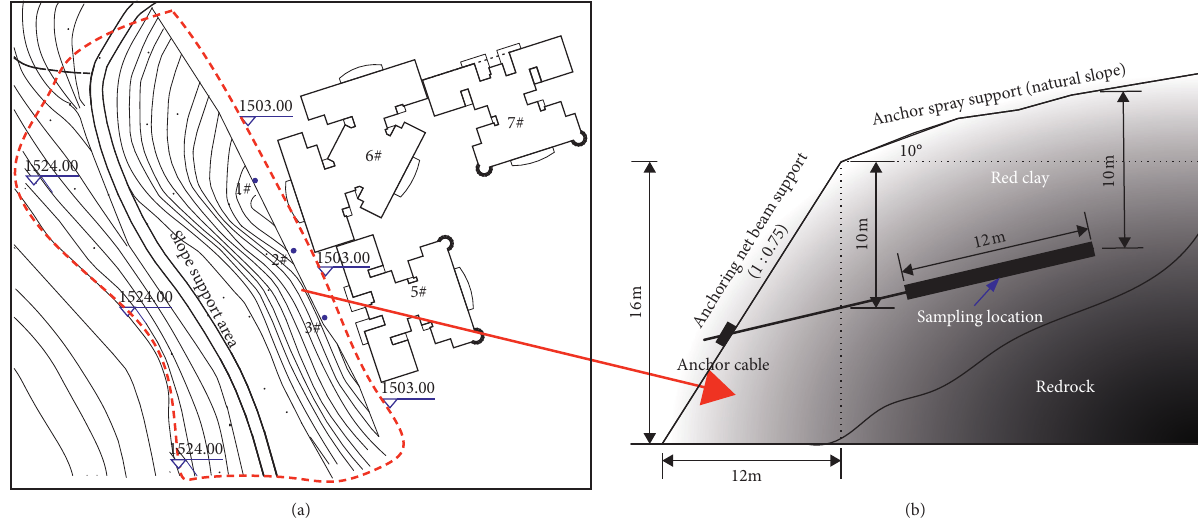
Figure 16: (a) Slope and anchor cable location map of the test site. (b) Test site slope profile. Table 2: Basic parameters and experimental data of the anchor cable.